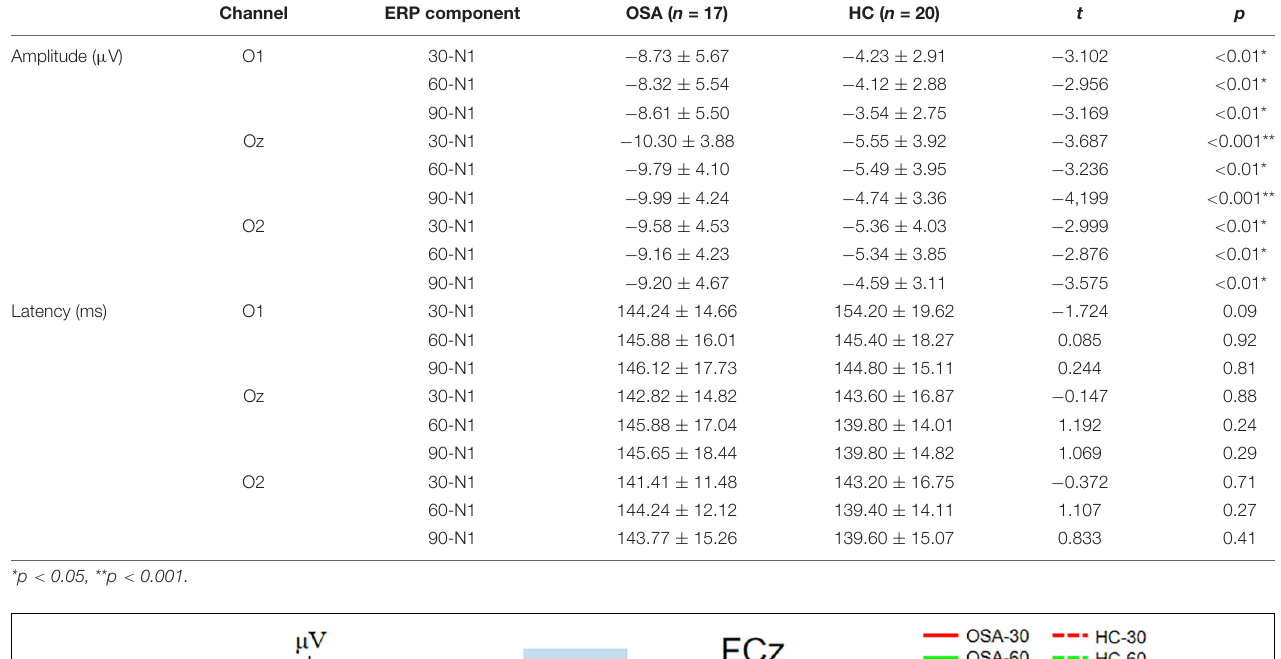
TABLE 3 | The amplitude and latency of each event-related potential (ERP) component in the OSA group and healthy control group ( M ± SD ). Channel